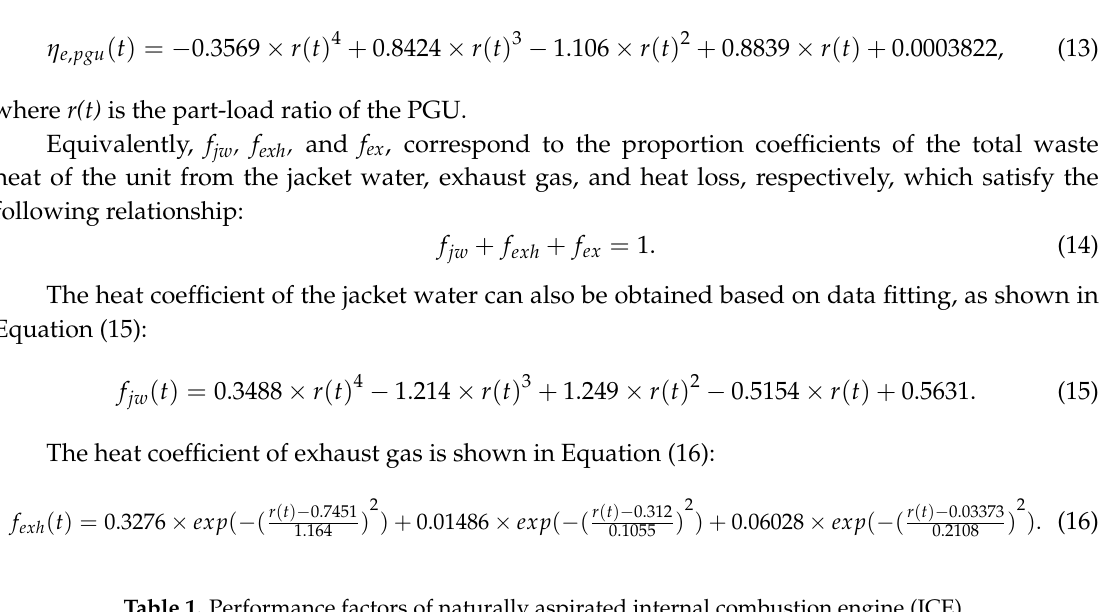
Table 1. Performance factors of naturally aspirated internal combustion engine